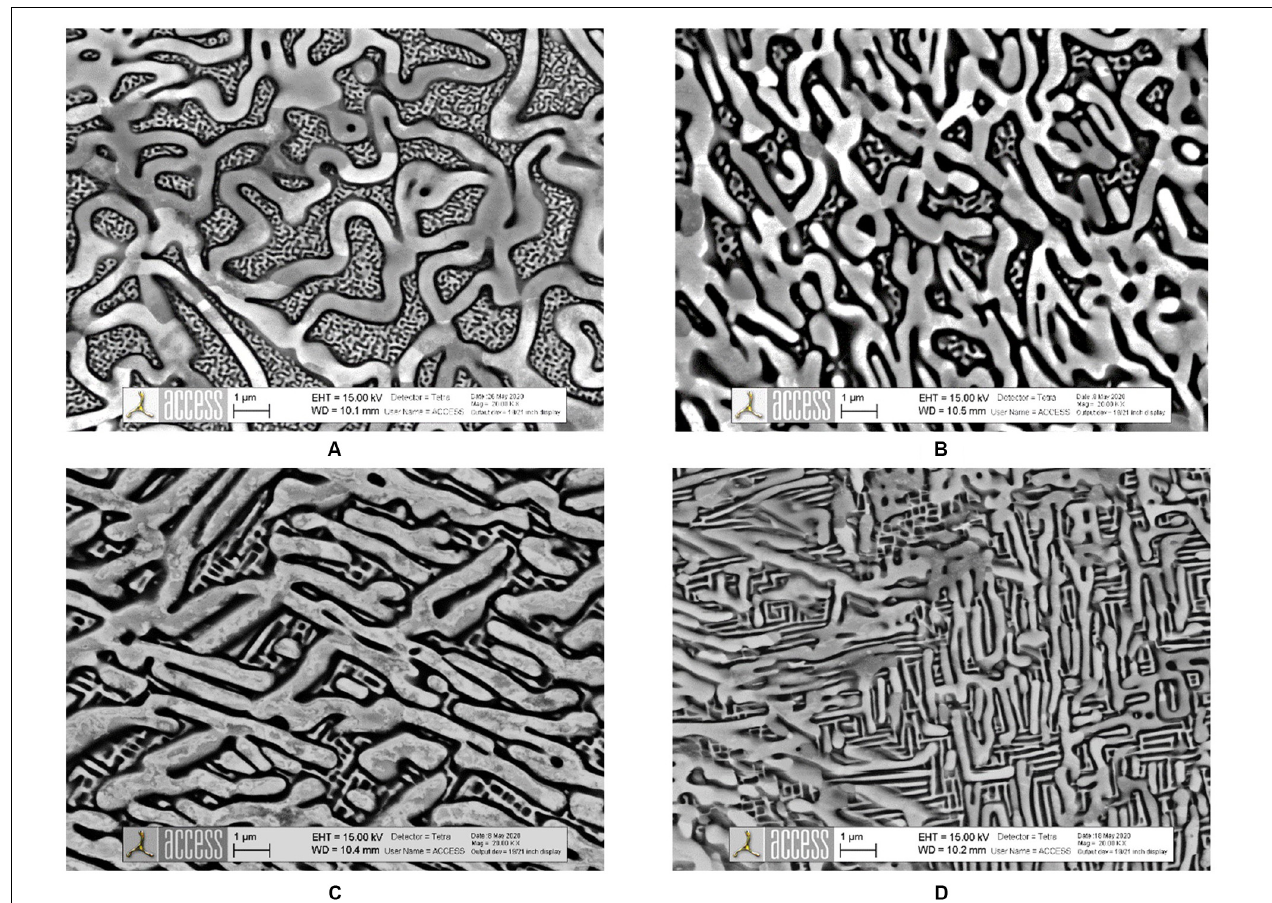
FIGURE 2 | SEM-BSE images of the ultrafine vermicular duplex structure in as-cast Mo x samples, showing increasing morphological anisotropie with increasing Mo: (A) Mo-free, (B) 1 Mo, (C) 2 Mo, and (D) 3 Mo (at.-%). TABLE 2 | Morphological and crystallographic features of the FCC phase in of Mo 0 and Mo 2 : Phase fraction, average thickness, average and 95th percentile intergranular misorientation. Sample FCC phase fraction (%) Average thickness ( µ m) Intergranular misorientation ( ◦ ) Mo 0